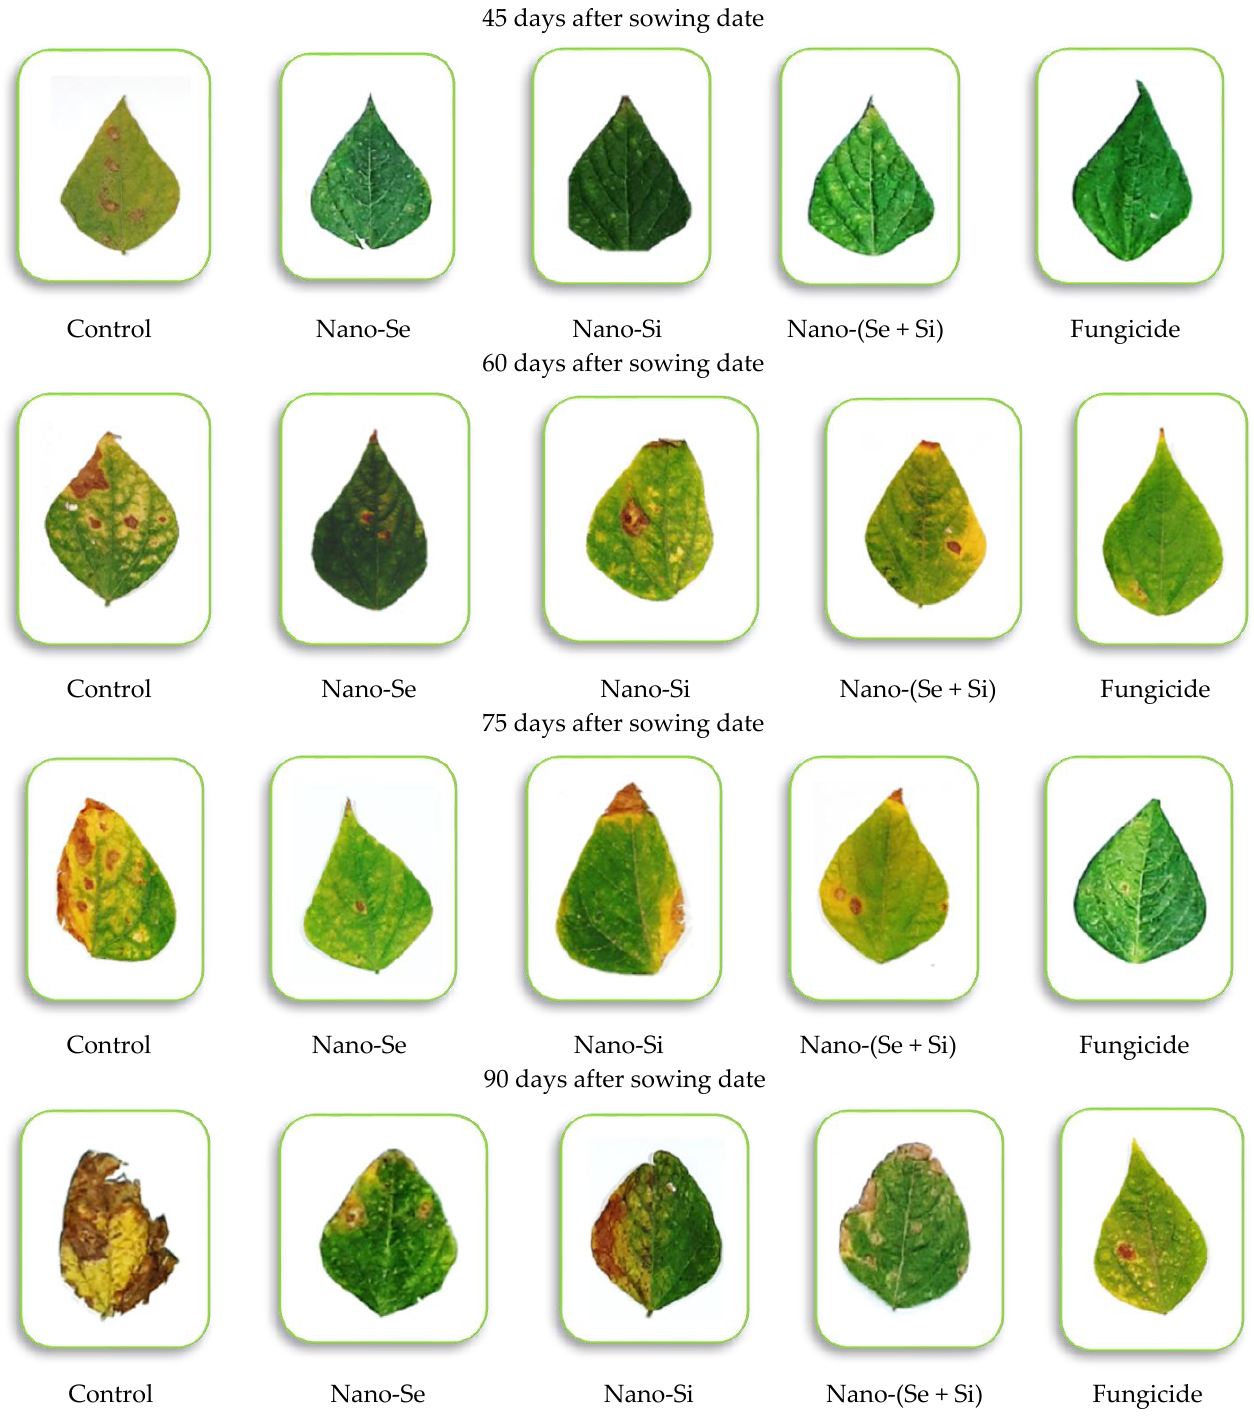
Figure 6. Effects of the various treatments on the development of leaf spot disease caused by A. alternata on common bean plants (Giza 12, cv.) grown in the field and sampled 45, 60, 75, and 90 days after sowing, and where Control = no treatment, Nano-Se = 100 ppm nano-Se, Nano-Si = 200 ppm nano-Si, Nano-(Si + Si) = combined 1/2 dose of nano-Se + nano-Si, and Fungicide = Score 250 EC at 1 mL/2 L.